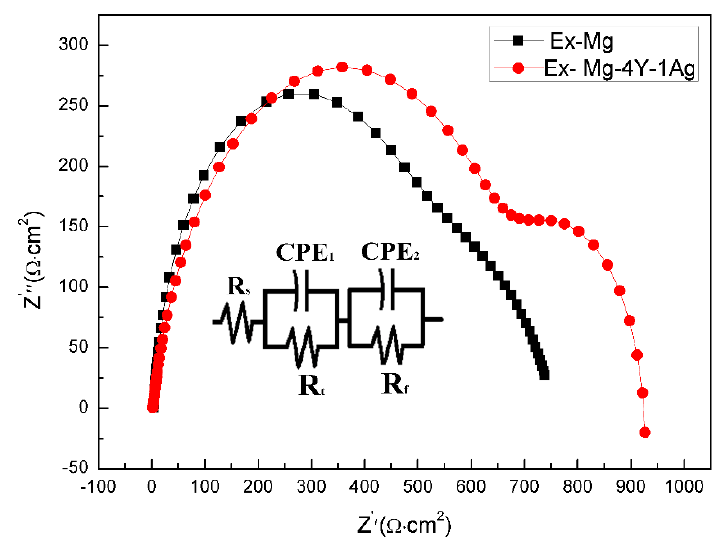
Figure 5. The EIS plots and the equivalent circuit of Mg and Ex ‐ Mg ‐ 4Y ‐ 1Ag. Table 3. Electrochemical parameters of Mg and Ex ‐ Mg ‐ 4Y ‐ 1Ag alloy from the electrochemical impedance spectroscopy.